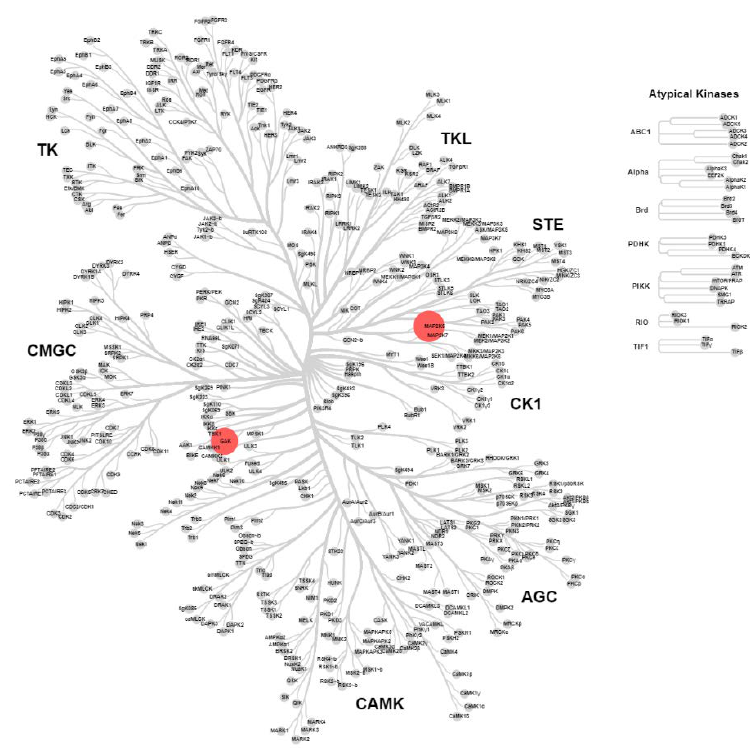
Figure 3. Representation of the human kinome based on sequence identity displaying KINOMEscan ® results for compound 15 screened at 1 µM. Red dots represent kinases inhibited by >75%, differentiated by size; kinases inhibited at 1 µM MEK5, 92% and GAK, 78% (see Supplementary Materials).